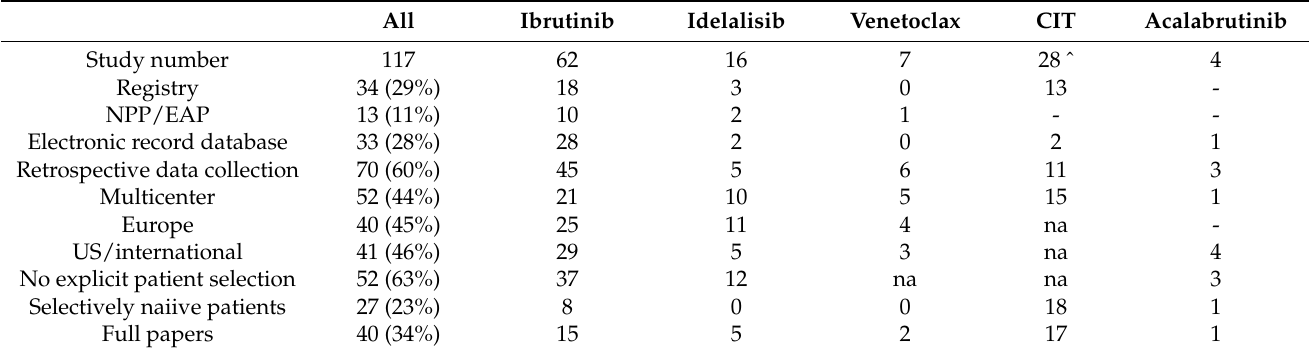
(Table 3): median PFS and OS among the studies was 42 and 74 months, respectively. Table 2. Real-world studies.